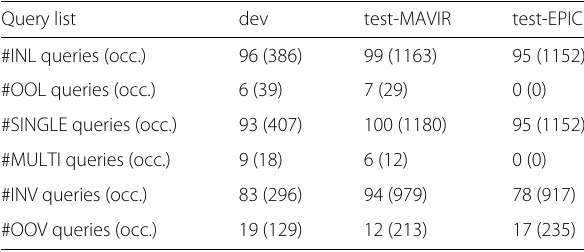
Table 3 Statistics of the development and the test query lists for the MAVIR and the EPIC databases Query list dev test-MAVIR test-EPIC #INL queries (occ.) 96 (386) 99 (1163) 95 (1152) 7 (29) 0 (0) #SINGLE queries (occ.) 93 (407)